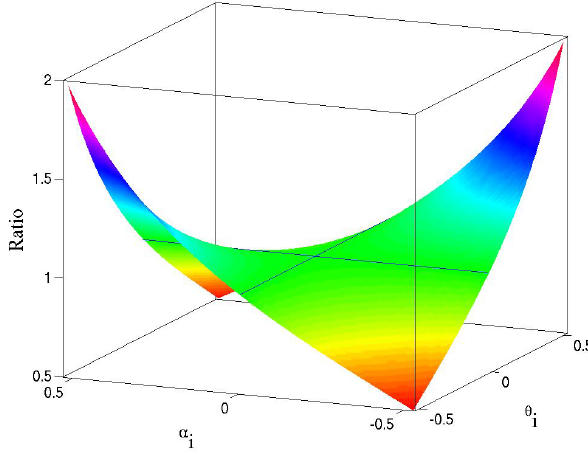
Figure 8. Mechanism allowing underactuation between the fingers and coupling with the thumb. The thumb has been removed for clar- ity. The thumb tendon is attached at the centre of the large seesaw. Figure 9. Ratio of the output forces of a triangular seesaw as a function of the floating body geometry ( θ i ) and orientation ( α i